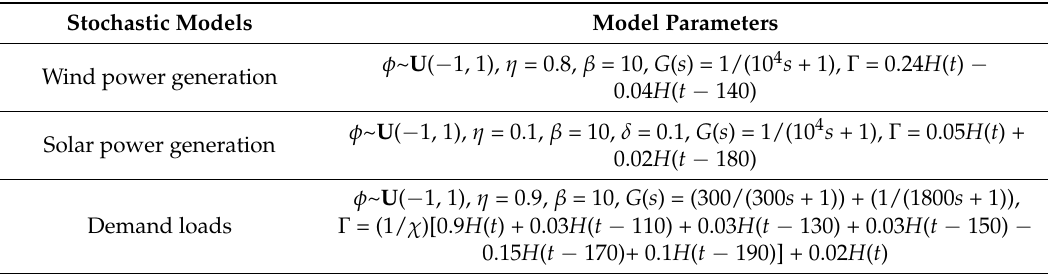
Table 2. The parameters of stochastic models for distributed generators and demand